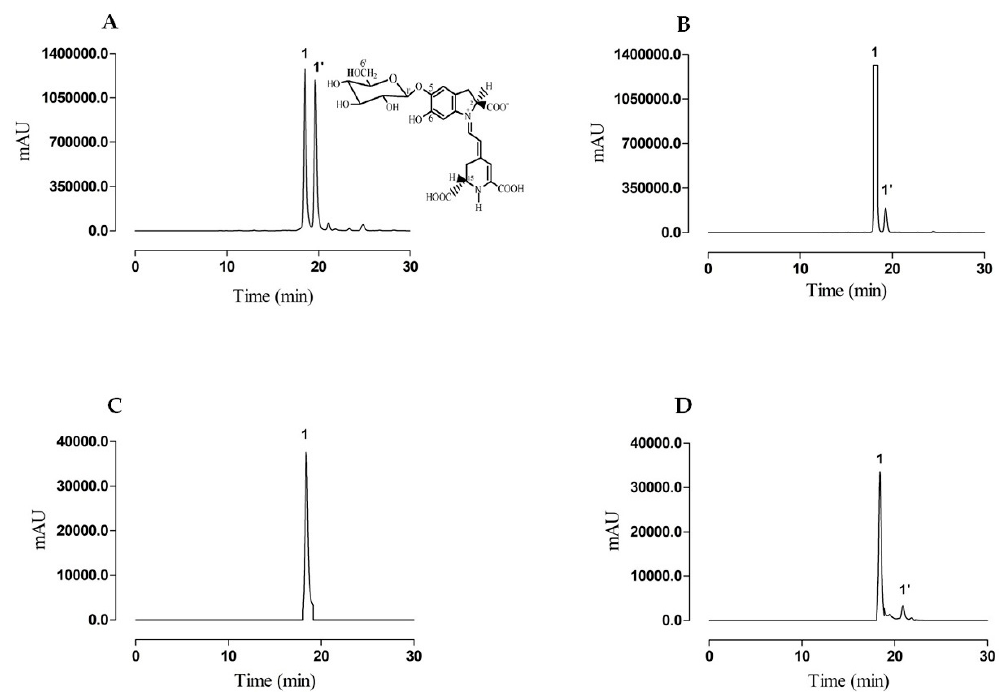
Figure 1. Betanin separation by high-performance liquid chromatography diode array detector (HPLC-DAD) monitored at 536 nm. ( A ) Betanin standard chromatographed in the analytical